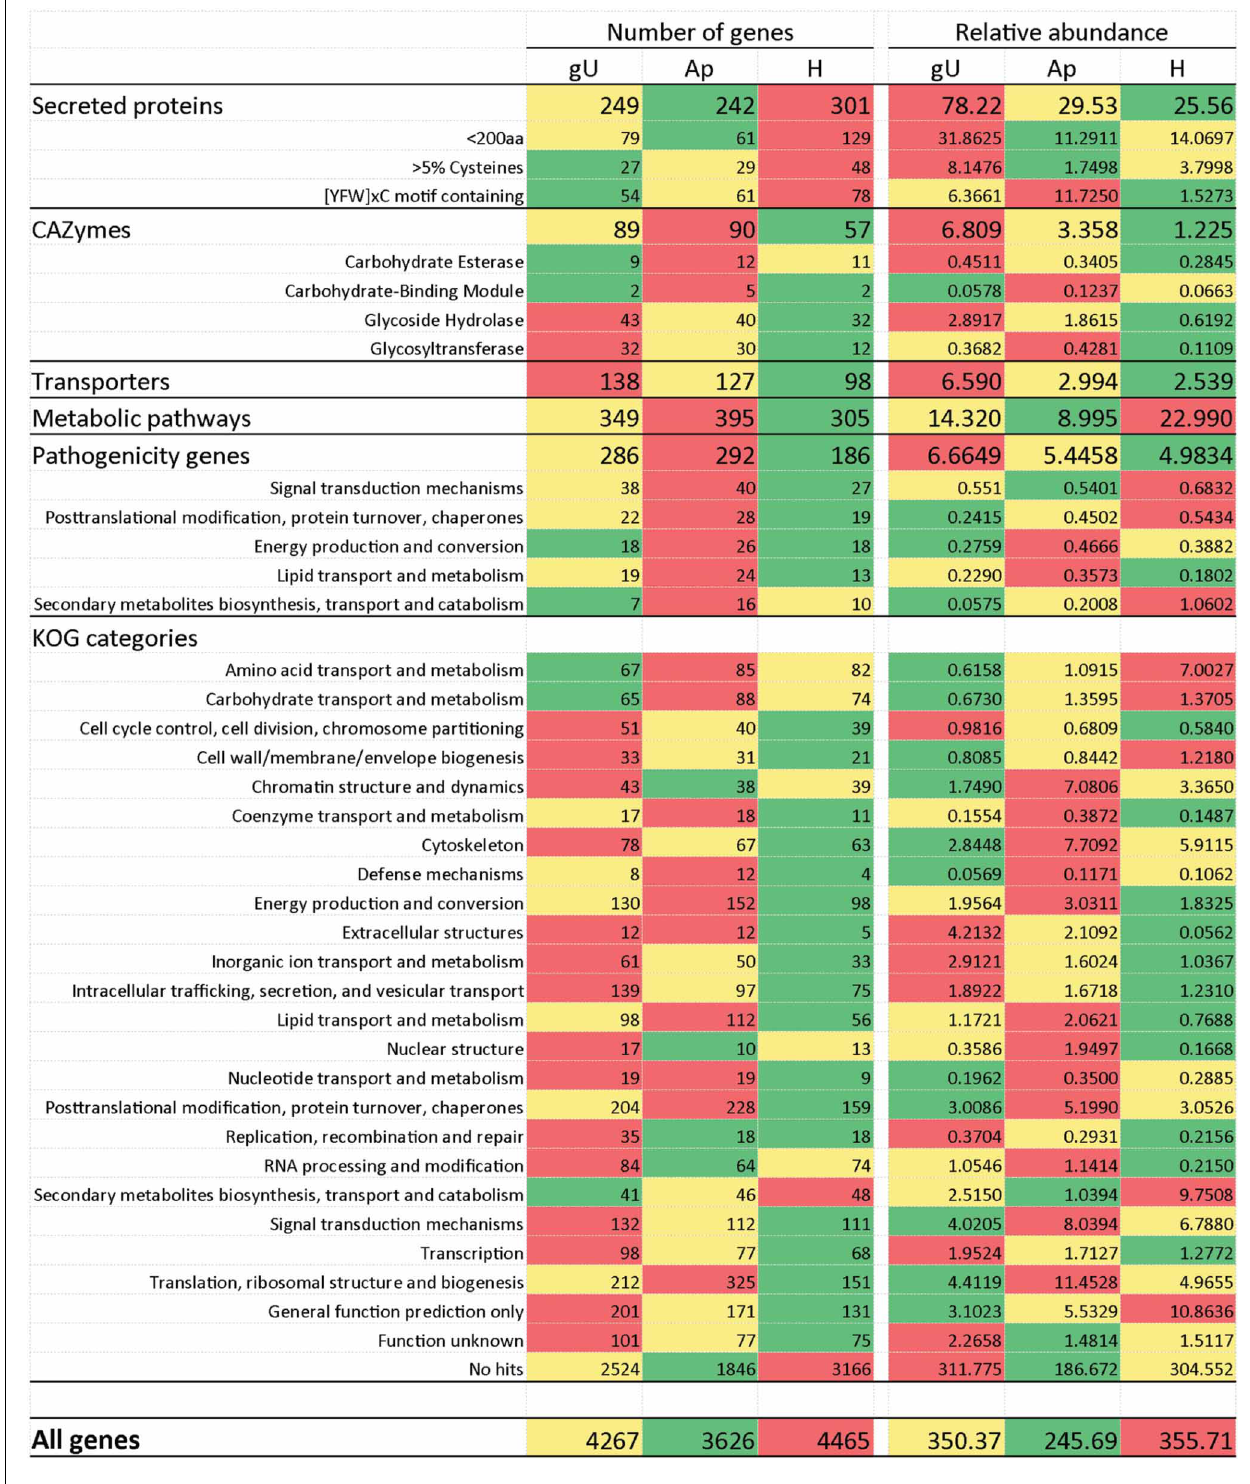
infected leaves 21 days after inoculation, H) for transcripts according to the main categories under analysis. Color scale: green to red denote lowest to highest expression values for each